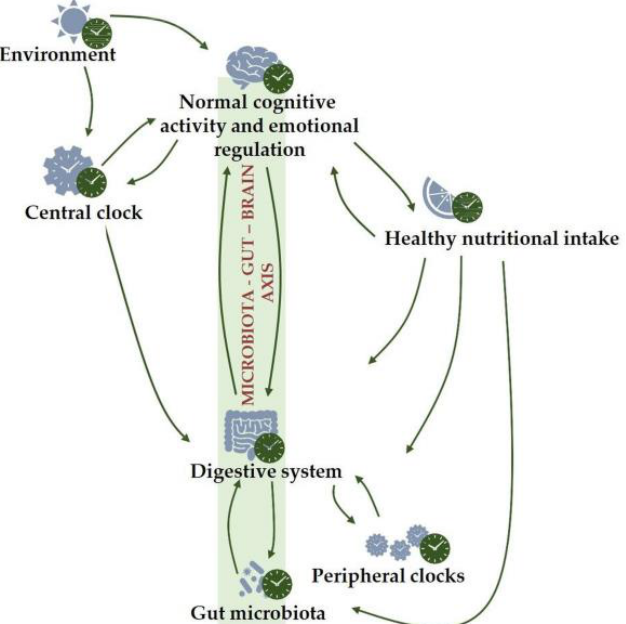
Figure 2. Depiction of circadian rhythms, the gut microbiota, and their interaction and effect on gut and mental health in healthy individuals. Circadian rhythms strongly influence cognition, mood and behavior, and brain function, which in turn, strongly impact circadian health. Food intake that is temporally coordinated by the brain over the circadian (~24 h) cycle impact on brain functioning largely by shaping gut microbiota and intestinal homeostasis.